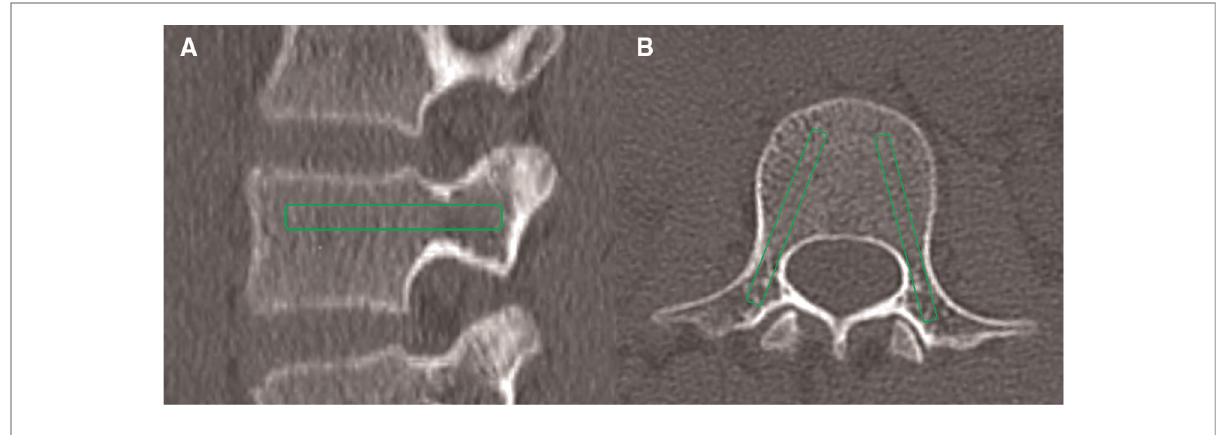
FIGURE 3 Schematic diagram of PST-HU measurement: the PST-HU was obtained on the sagittal plane ( A ) and the transverse plane ( B ).